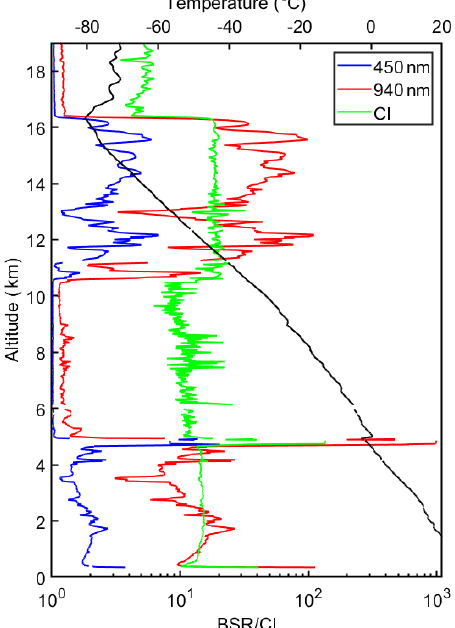
Figure 3. Backscatter ratio (BSR) at the 450nm (blue) and 940nm (red) channels were obtained using a COBALD sonde launched dur- ing the second pilot campaign (8 July 2017). The colour index (CI) estimated from BSRs at both channels is also shown (in